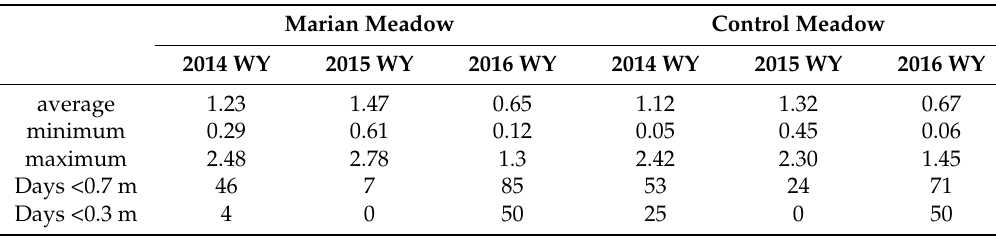
table depths were <0.7 m and <0.3 m for Marian Meadow and the Control Meadow for WY 2014–2016. Marian Meadow Control